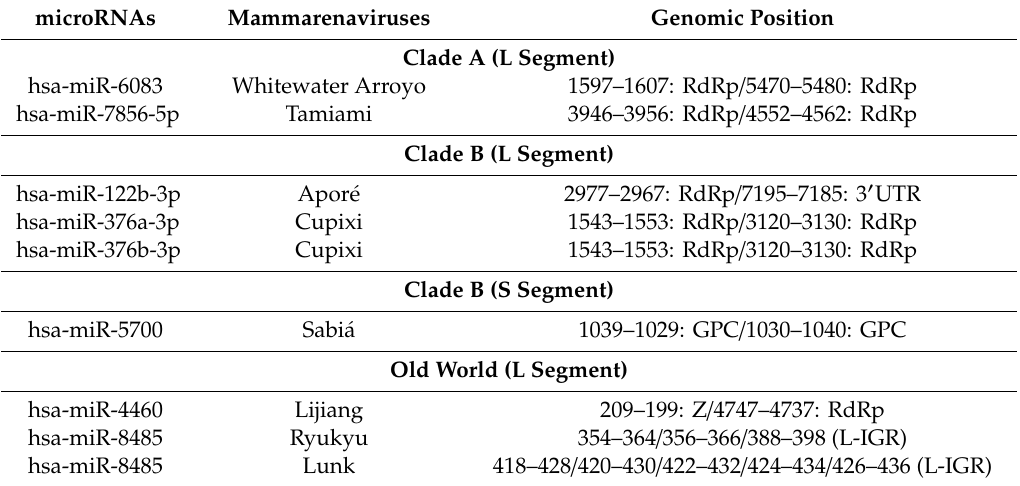
Table 4. MicroRNAs biding to di ff erent regions of the same mammarenavirus genomic